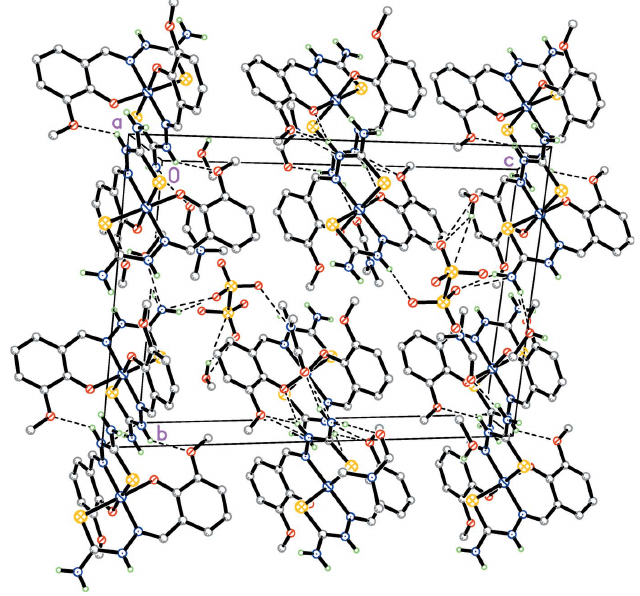
Figure 1 The molecular structure of the title compound with the atom-labeling scheme. Displacement ellipsoids are drawn at the 30% probability level. Solvent molecules (dimethylformamide and methanol) are omitted for clarity.